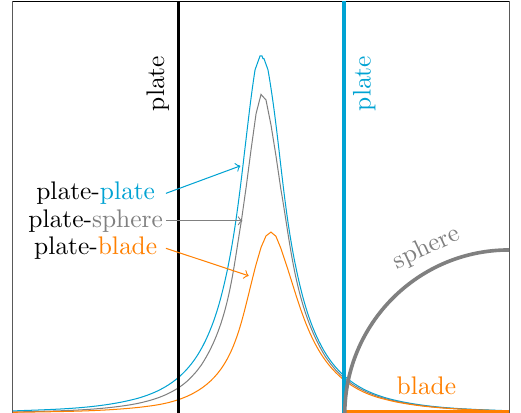
Fig. 6 Plot of validation runs for plate-plate and plate-sphere cases. The plot also includes a plate-blade case. The geometry elements are represented by a thick vertical black line for the left Casimir cavity plate, a thick vertical cyan line for the right plate, a thick gray quarter circle to show the location of the sphere, and an orange horizontal line representing the blade. The colors of the plots of energy density distributionmatchthecolorofthecorrespondinggeometryoverlayedin the plot. The magnitude of the energy density distribution clearly shows a decrease in magnitude as the cases go from plate-plate to plate-blade. Additionally, the plots show that there is a shifting of the peaks to the right due to the curvature effects